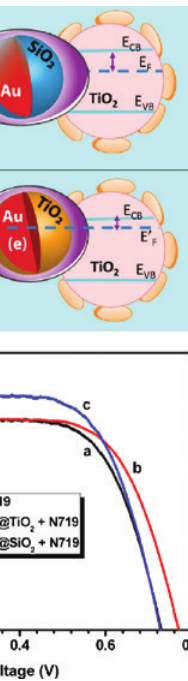
): dye-TiO /Au@SiO , and dye-TiO /Au@TiO , F 2 2 2 2 /Au@SiO and TiO /Au@ 2 2 2